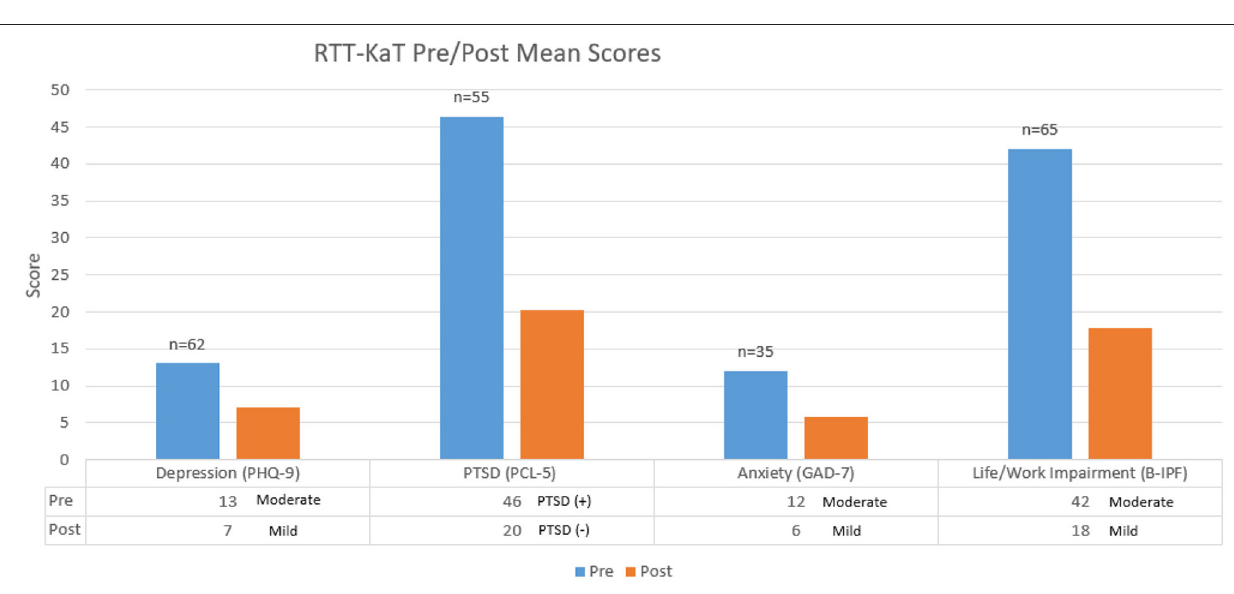
FIGURE 2 | Cohort 1, 2, and 3 aggregate: mean scores. The “ n ” represents the number of participants who screened positive for PTSD, depression, or generalized anxiety disorder upon entry into the RTT-KaT program. The pre-results were taken within 1 month of the program beginning and post results were taken directly after the 12-week program was completed. If data was missing, it was not